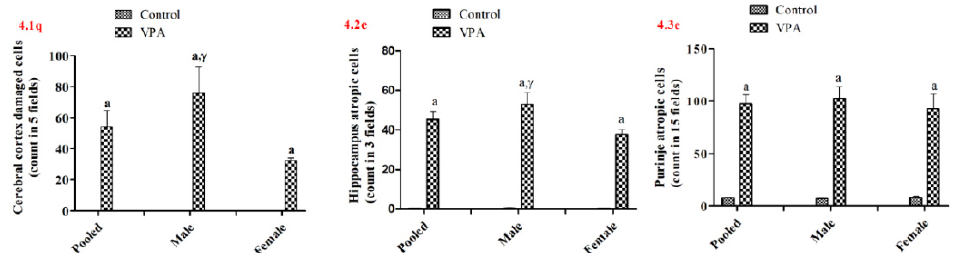
Figure 4. ( 4.1 ) Photomicrographs of sections of cerebral cortex. ( a – d ) Control male animals showed normal neurons in cerebral, prefrontal, frontal and temporal cortex. VPA male animals showed ( e ) chronic inflammatory cells in cerebral cortex, ( f ) degenerated or apoptotic neurons in prefrontal cortex, ( g ) inflammation in frontal cortex and ( h ) inflammatory cells in temporal lobe of cerebral cortex. ( i – l ) Control female animals showed normal neurons in cerebral, prefrontal, frontal and temporal cortex. VPA female animals showed ( m , o , p ) normal neurons in cerebral, frontal and temporal cortex and ( n ) focal gliosis in prefrontal cortex. ( q ) Number of cerebral cortex damaged cells in sex-matched VPA-treated animals compared to sex-matched controls. Damaged cerebral cortex neurons were counted with 5-field analysis using a microscope. ( 4.2 ) Photomicrographs of hippocampus. ( a , c ) Sex-matched control groups showed normal hippocampal neurons; ( b ) atrophic neurons in hippocampus of VPA-treated male animals; ( d ) atrophic neurons in hippocampus of VPA-treated female animals; CA, Cornu Ammonis; DG, Dentate gyrus; ( e ) number of atrophic hippocampal cells in sex-matched VPA-treated animals compared to sex-matched controls. Damaged hippocampal neurons were counted with 3-field analysis using a microscope. ( 4.3 ) Photomicrographs of sections of cerebellum. ( a , c ) Sex-matched control animals showed normal Purkinje layer; ( b ) atrophic Purkinje neurons in VPA-treated male animals; ( d ) atrophic Purkinje neurons in VPA-treated female animals. PL, Purkinje layer; ML, molecular layer; GL, granular layer; ( e ) atrophic Purkinje cells in sex-matched VPA-treated animals compared to sex-matched controls. Damaged Purkinje neurons were counted with 15-field analysis using a microscope. Scale bar: 100 µ m. Final magnification 10 × . Data expressed as mean ± SEM. Pooled, n = 12; males, n = 6; females, n = 6. a p < 0.001, b p < 0.01, c p < 0.05 vs. sex-matched controls; α p < 0.001, β p < 0.01, γ p < 0.05 vs. VPA-treated female mice (using t -test), n.s, non-significant ( p >